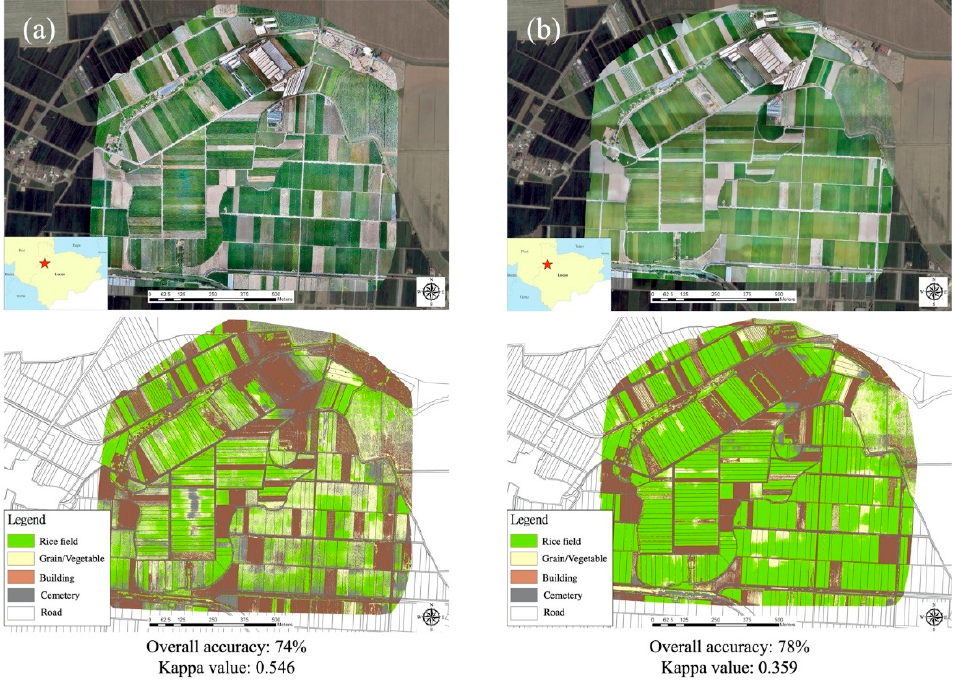
Figure 3. Interpretation accuracy at the Lucao sampling site. The orthophoto captured on ( a ) 17 August 2018; ( b ) 28 September 2018.